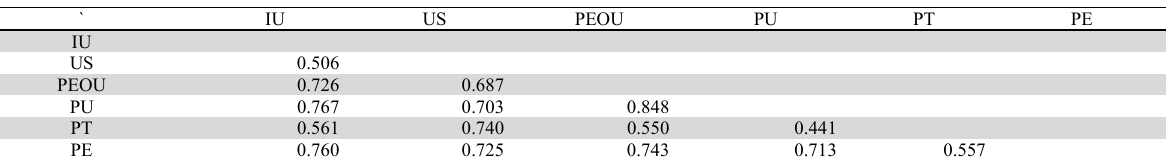
Heterotrait-Monotrait Ratio